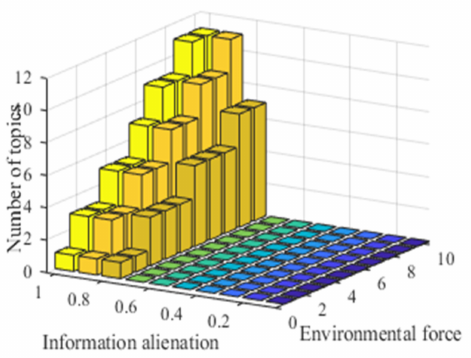
Figure 18. Analysis of the combination of factors influencing the number of derived